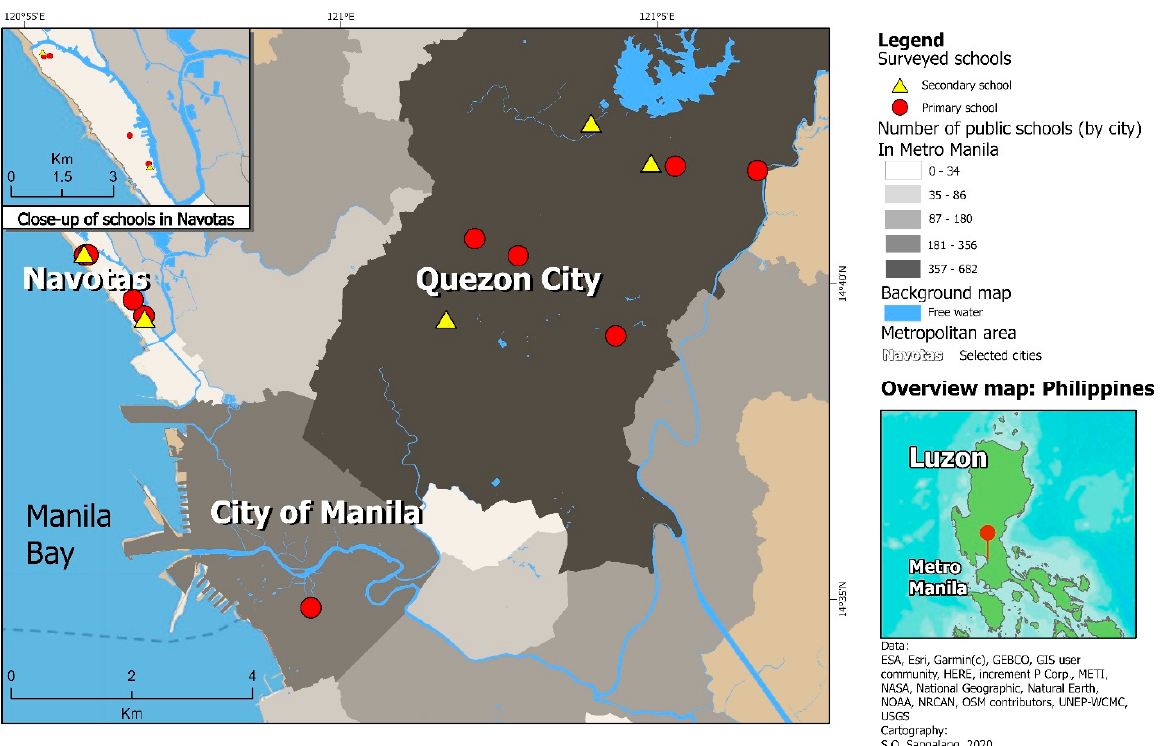
Figure 4. Map of study area with points marking the location of study schools. The map shows the study area in the National Capital Region, also known as Metro Manila, in northern Philippines, with study schools plotted as points. The red pushpin marker in the lower left inset map indicates where the location of the study area is within the Philippines, specifically in the northern most island group of Luzon.